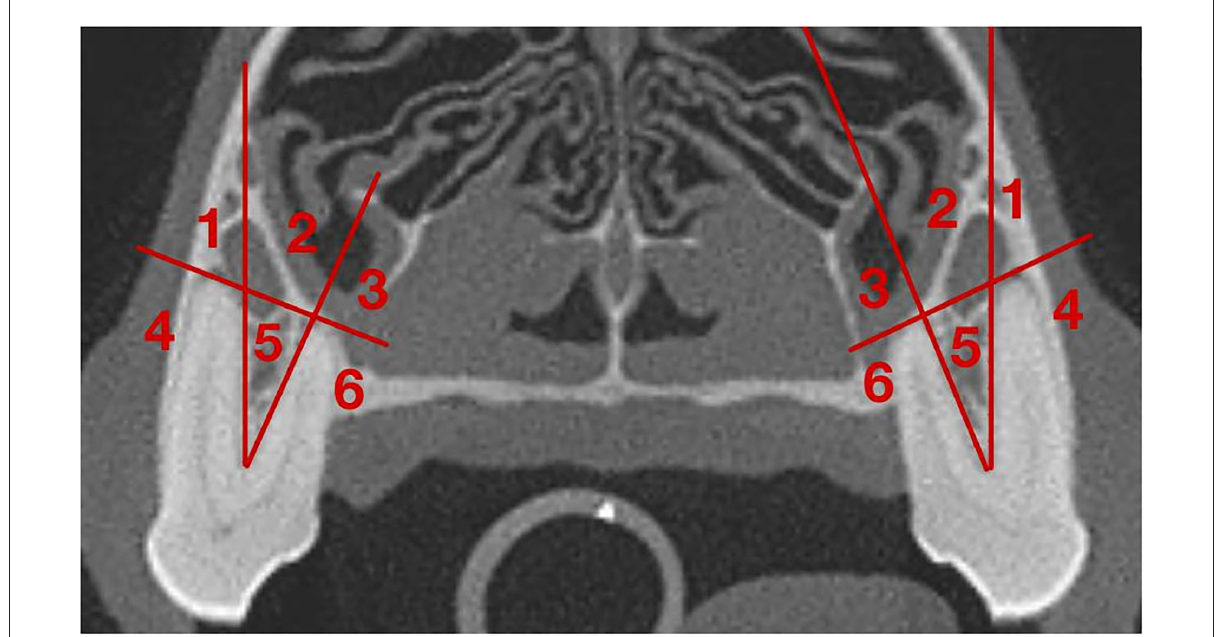
FIGURE1 Grid for the IOC relative to the mesial roots of the P4. (1) Section 1: Directly Apical to the mesiobuccal root; (2) Section 2: Apical to the furcation of the mesial roots; (3) Section 3: Directly apical to the mesiopalatal root; (4) Section 4: Buccal to the mesiobuccal root; (5) Section 5: In the furcation of the mesial roots; (6) Section 6: Palatal to the mesiopalatal root.